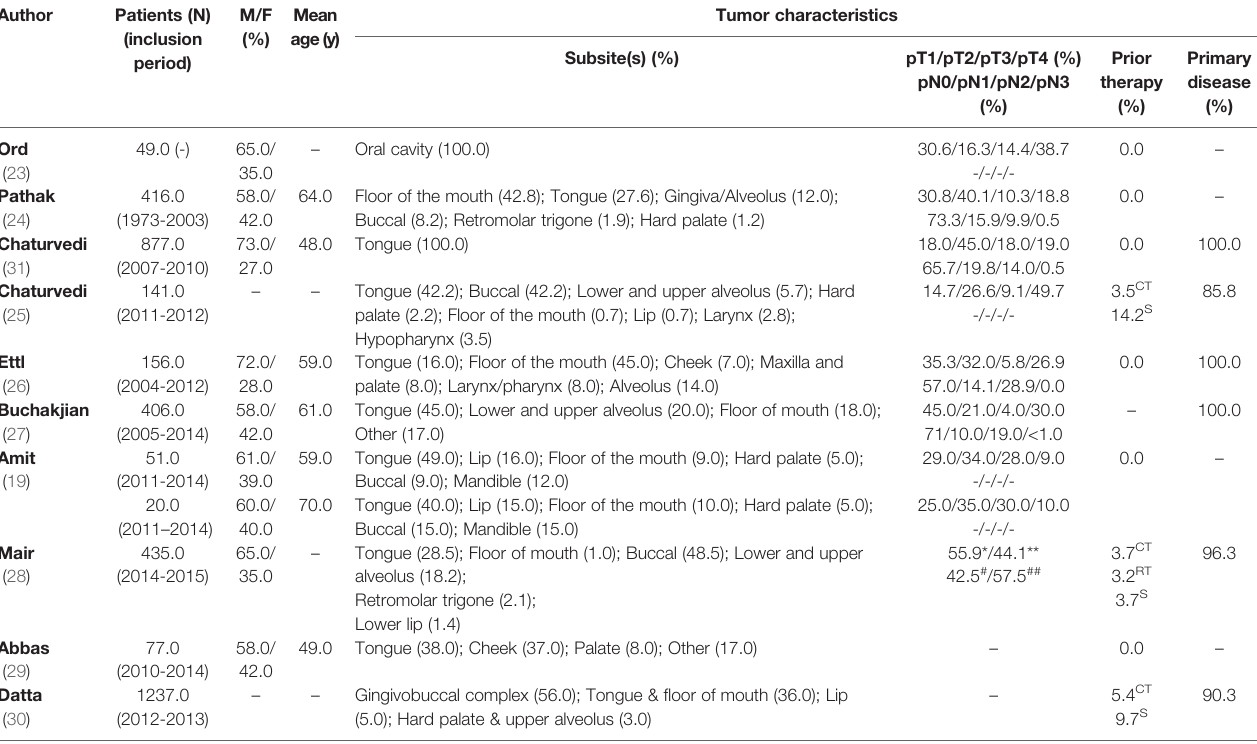
TABLE 1 | IOARM in soft tissue: patients and tumor